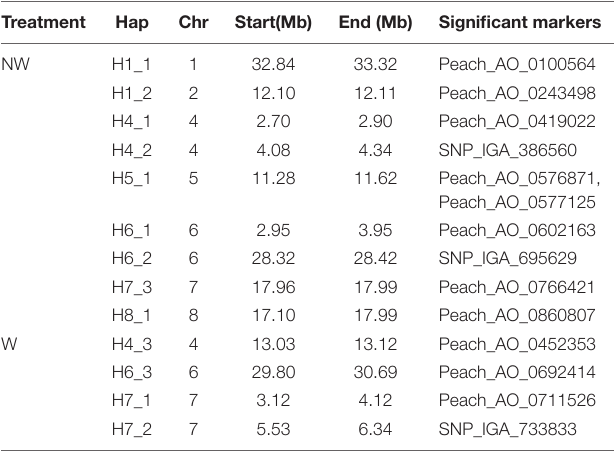
TABLE 4 | Haploblocks encompassing markers significantly associated with brown rot response in peach fruit skin and flesh.